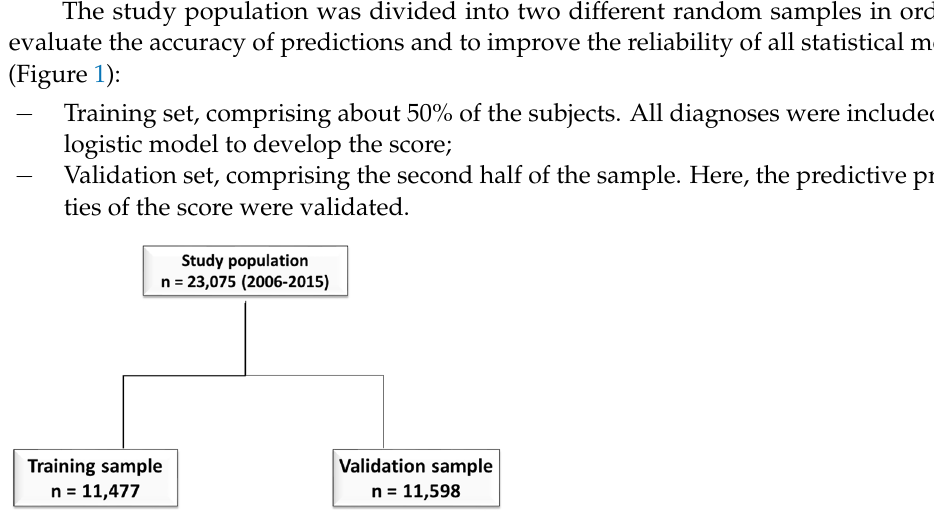
Figure 1. Flowchart of the study